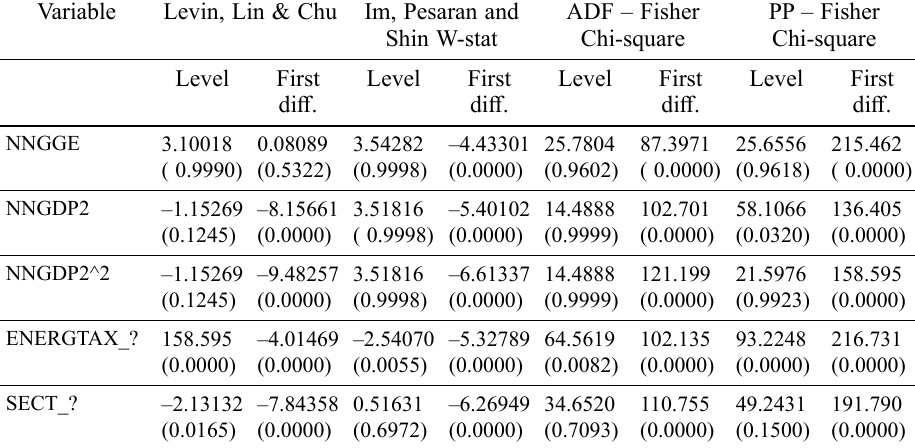
Table 2. Pool unit root tests: